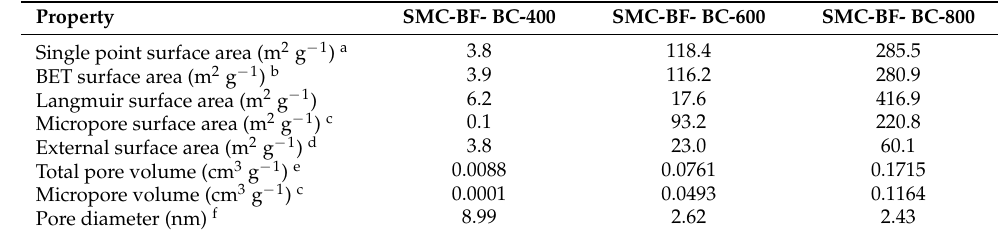
Table 3. Pore properties of biochar (BC) products prepared from SMC-BF at 400–800 ◦ C.